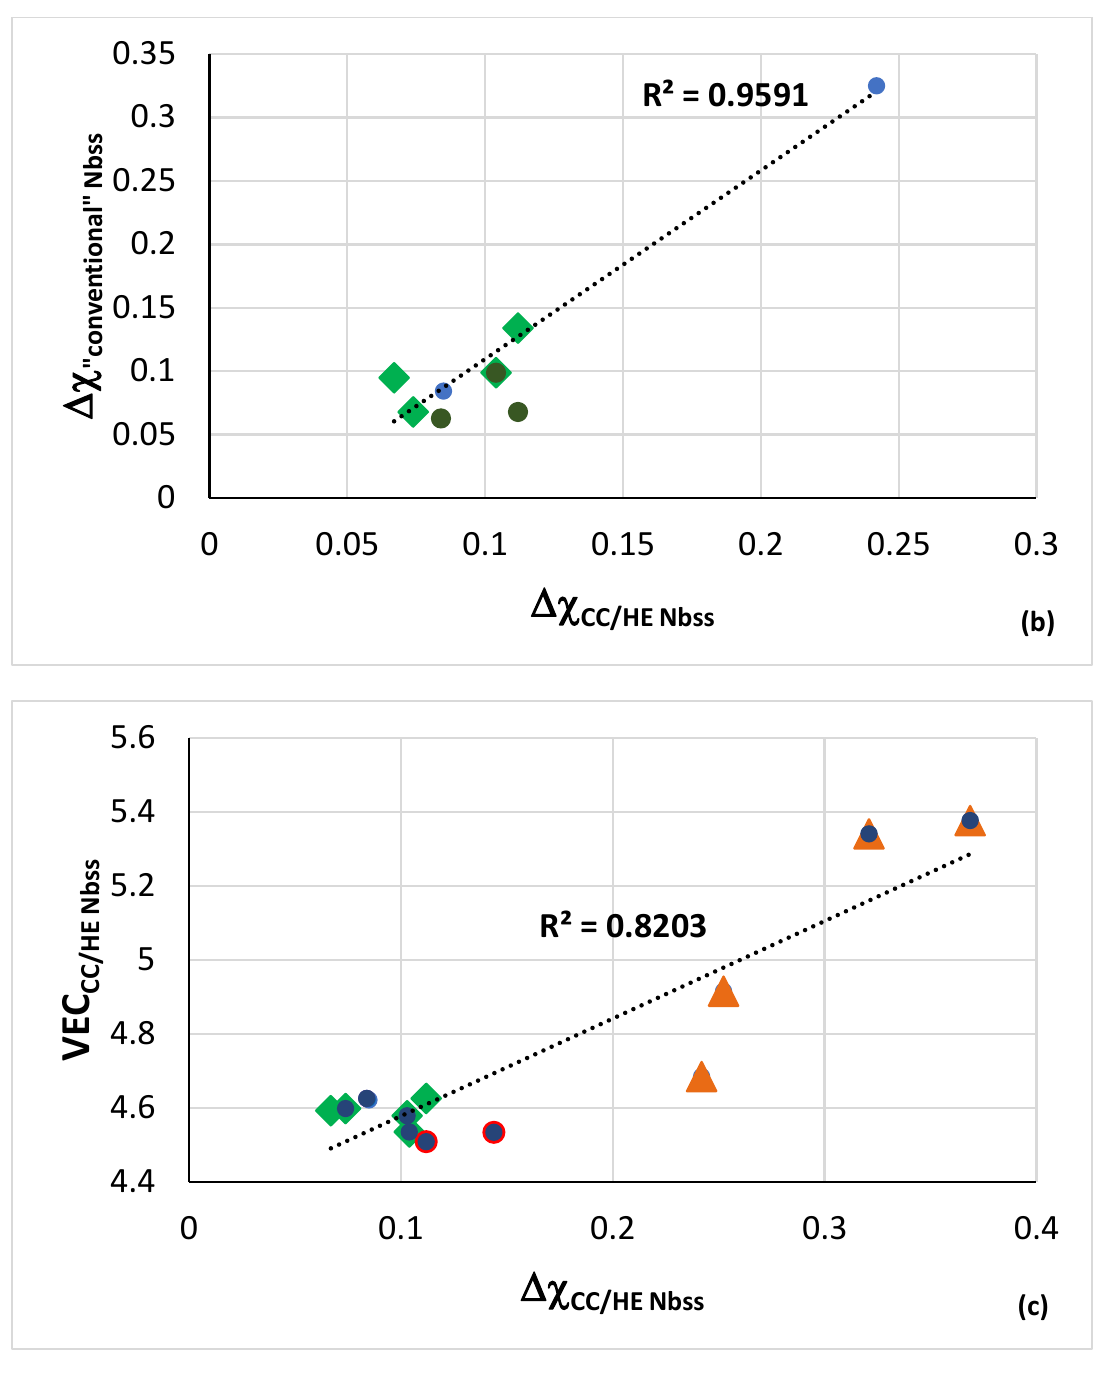
Figure 6. ( a ) ∆ χ alloy versus ∆ χ CC/HE Nbss , where green colour indicates B containing alloys and diamonds are for RM(Nb)ICs/RCCAs. ( b ) ∆ χ ”conventional” Nbss versus ∆ χ CC/HE Nbss , where green diamonds are solid solutions in B containing alloys and green circles for solid solutions in RM(Nb)ICs/RCCAs, ( c ) VEC CC/HE Nbss versus ∆ χ CC/HE Nbss , where green diamonds are for solid solutions in B containing alloys, brown triangles are for solid solutions in alloys with simultaneous addition of Ge and Sn, red circles are for solid solutions with Sn, and blue circles are for solid solutions in RM(Nb)ICs/RCCAs. In each part the R 2 value is for the linear fit of all the data. ( a , c ) data for the AC alloys EZ8, JG6, JZ3, JZ3+, KZ6, TT4, TT5, TT7, TT8, ZF9 and the HT alloys JZ5 and TT5, ( b ) data for the AC alloys KZ6, TT4, TT5, TT7, TT8, ZF9. HE Nb ss in TT4-AC. See the Appendix A for nominal alloy compositions and references.